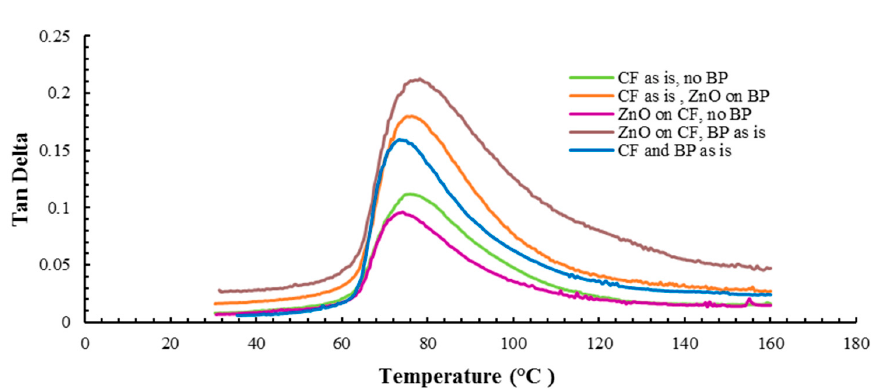
Figure 9. The variation of tan delta with temperature for the various composite configurations.